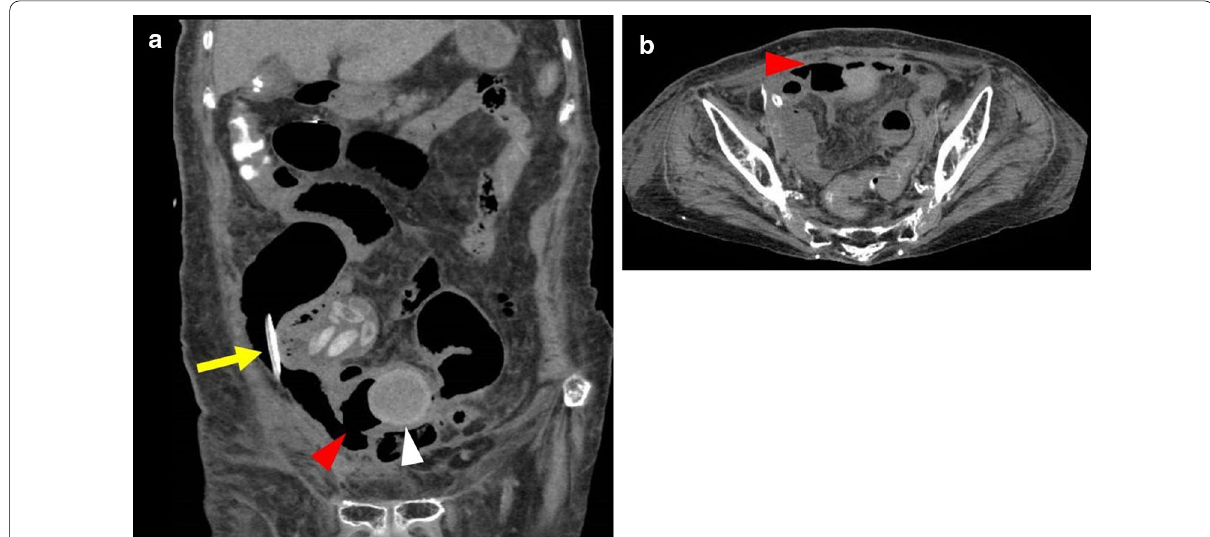
Fig. 2 Follow-up abdominal plain CT performed 10 days after onset. a Coronal and b transaxial images reveal that the abdominal free space, including gas and the drainage tube (yellow arrow), communicates with the intraluminal space of the small intestine, which contains a slightly high-density spherical structure (white arrowhead) in the vicinity, via the perforation site (red